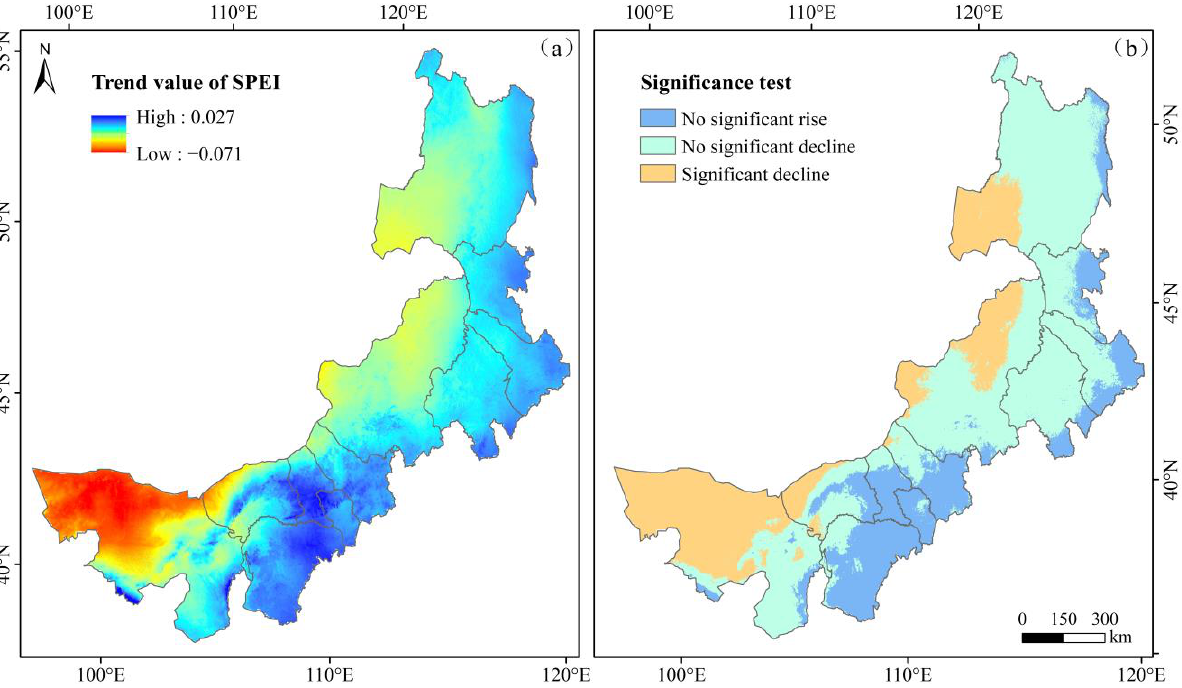
Figure 11. Change trends and significance tests of SPEI in space in Inner Mongolia. ( a ) shows the 38-year SPEI change trend values in Inner Mongolia calculated by the Theil – Sen median trend anal- ysis. Values greater than 0 represent wetting, and values less than 0 represent aridity. ( b ) are the